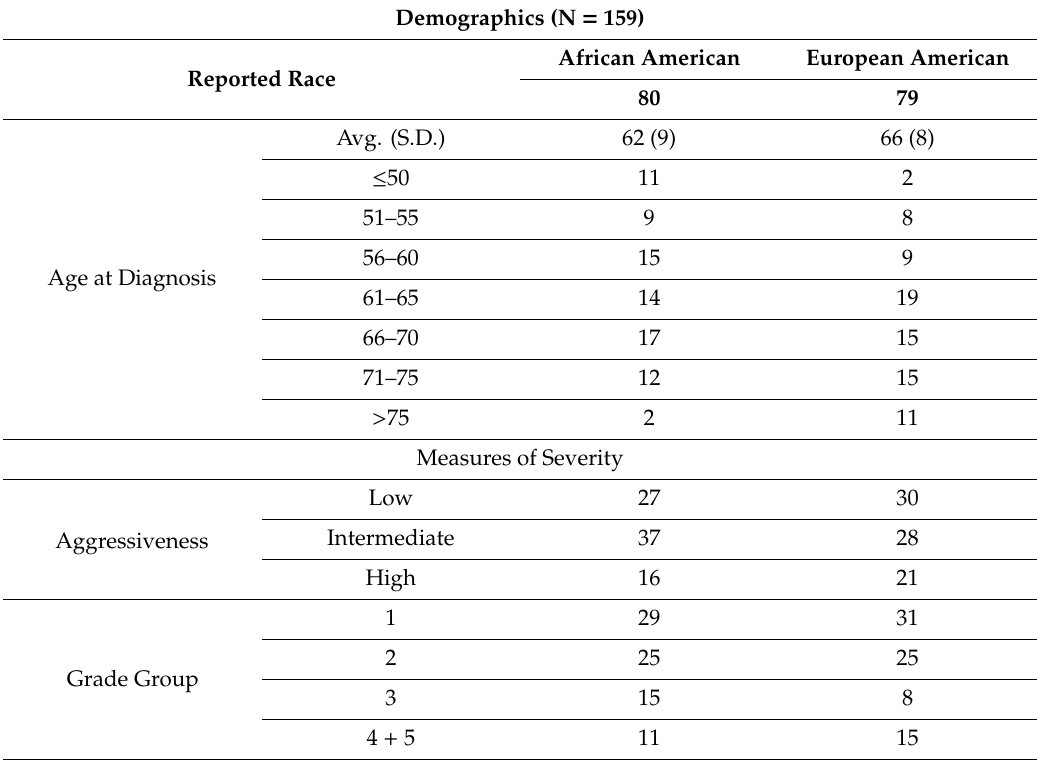
Table 1. Demographics for the PCaP cohort